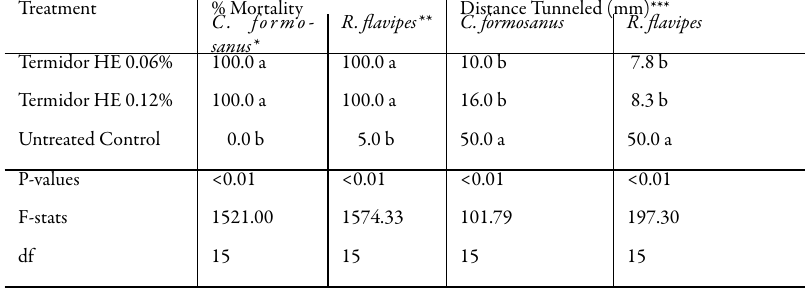
Table 1 . Mean percent mortality and distance tunneled by Coptotermes formosanus and Reticulitermes flavipes in soils treated with Termidor® HE Co-pack (two concentrations). Treatment % Mortality